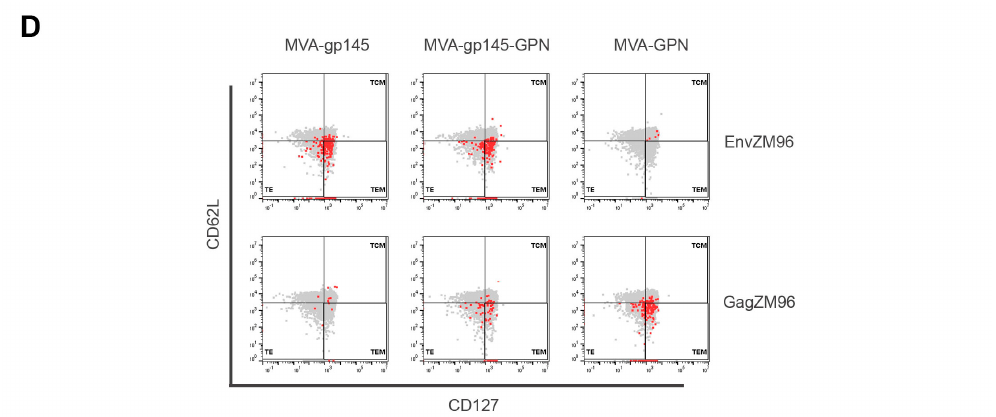
Figure 3. Polyfunctional HIV-1-specific CD4 and CD8 T cell immune responses elicited in spleen after prime/boost homologous immunization of mice with different MVA-based recombinant viruses expressing gp145 and/or GPN antigens. ( A ) Immunization schedule. Groups of 6–8-week-old female mice ( n = 5) received the indicated doses of MVA-based recombinant viruses by bilateral intramuscular route (i.m.); three weeks later, the animals were immunized with MVA constructions as in the prime and 10 days post-boost, mice were sacrificed, and the spleens and draining lymph nodes (DLNs) were processed for Intracellular Cytokine Staining (ICS) assay and sera harvested for Enzyme-Linked Immunosorbent Assay (ELISA) to measure the cellular and humoral adaptive immune responses against HIV-1 or VACV antigens, respectively. ( B ) Magnitude of the HIV-1-specific CD4 (left) or CD8 (right) T cells at 10 days post-boost by ICS assay after the stimulation of splenocytes with the different HIV-1 clade C peptide pools. The total value of each group represents the sum of the percentages of HIV-1-specific CD4 or CD8 T cells secreting CD107a and/or IFN- γ and/or IL-2 and/or TNF- α against different HIV-1 peptide pools. Data are background-subtracted. ***, p < 0.001. ( C ) Polyfunctional profile of the overall CD4 + T cell response in the different immunization groups. The thirteen positive combinations of the responses are indicated on the x axis, while the percentages of the functionally different cell populations within the total CD4 T cells are represented on the y axis. Non-specific responses that were obtained in the control group were subtracted in all populations. Specific responses are grouped and colour-coded based on the number of functions. C: CD107a; I: IFN- γ ; 2: IL-2; T: TNF- α . ***, p < 0.001. ( D ) Representative phenotypic profiles of the vaccine-induced memory CD4 T cell responses against Env(ZM96) or Gag(ZM96) peptide pools in the indicated immunization groups. The red dots indicate antigen-specific vaccine-induced CD4 + T cells overlaid on the total CD4 T cell subsets